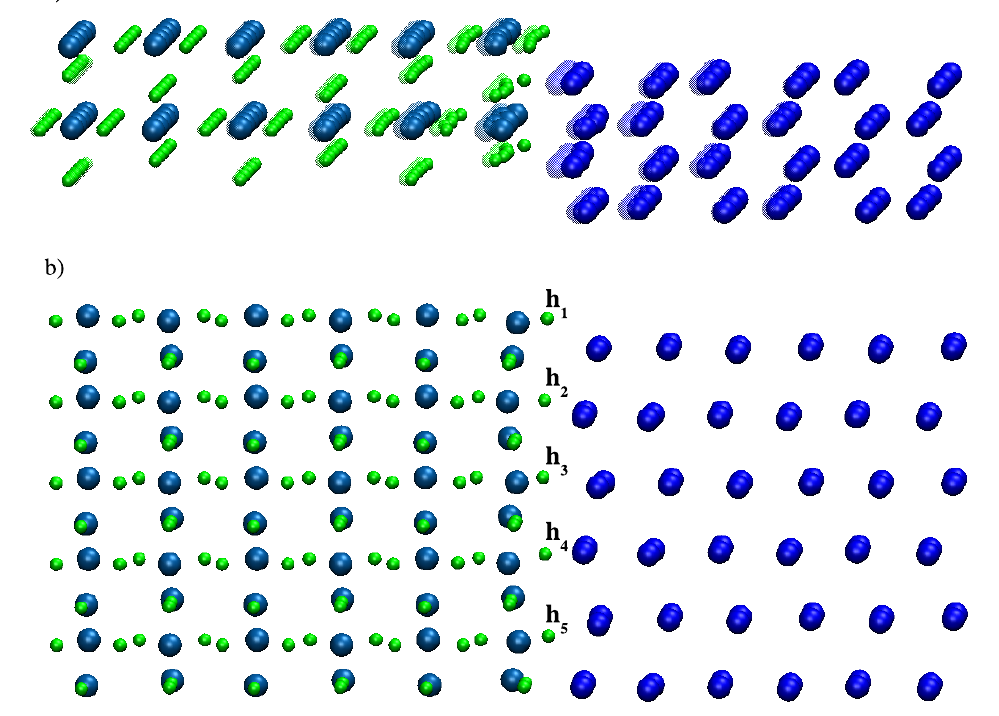
Figure 5. Two views of the Mg-MgH interface after ionic relaxation. The shadowed 2 atoms represent initial positions of atoms before relaxation. Displacements of the atoms are resumed in Table